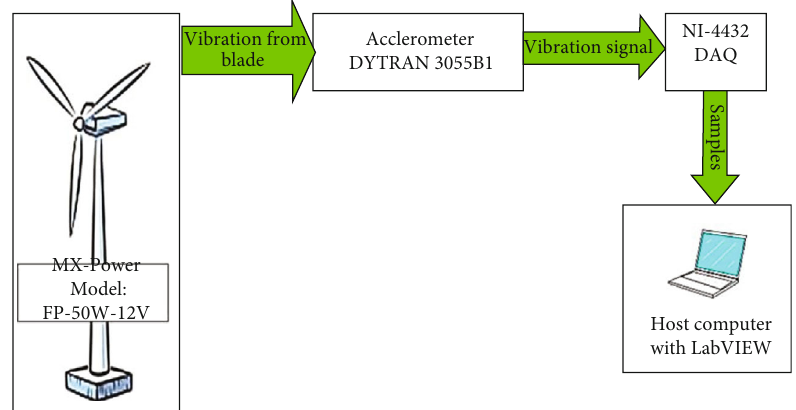
Figure 1: Methodology of the present